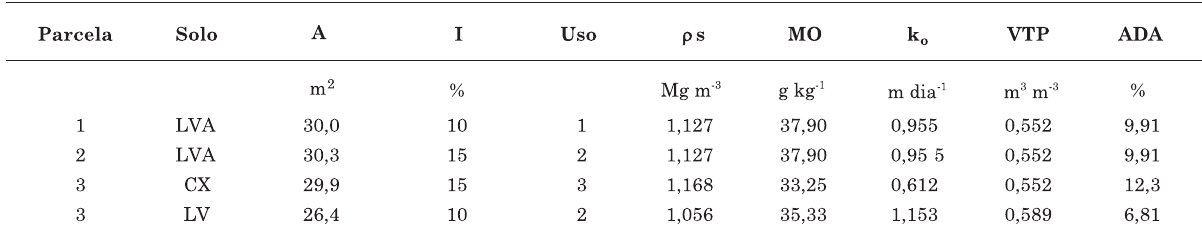
Quadro 1. Características fisiográficas e atributos físicos dos solos das parcelas de perda de solo instaladas na sub-bacia hidrográfica do Ribeirão